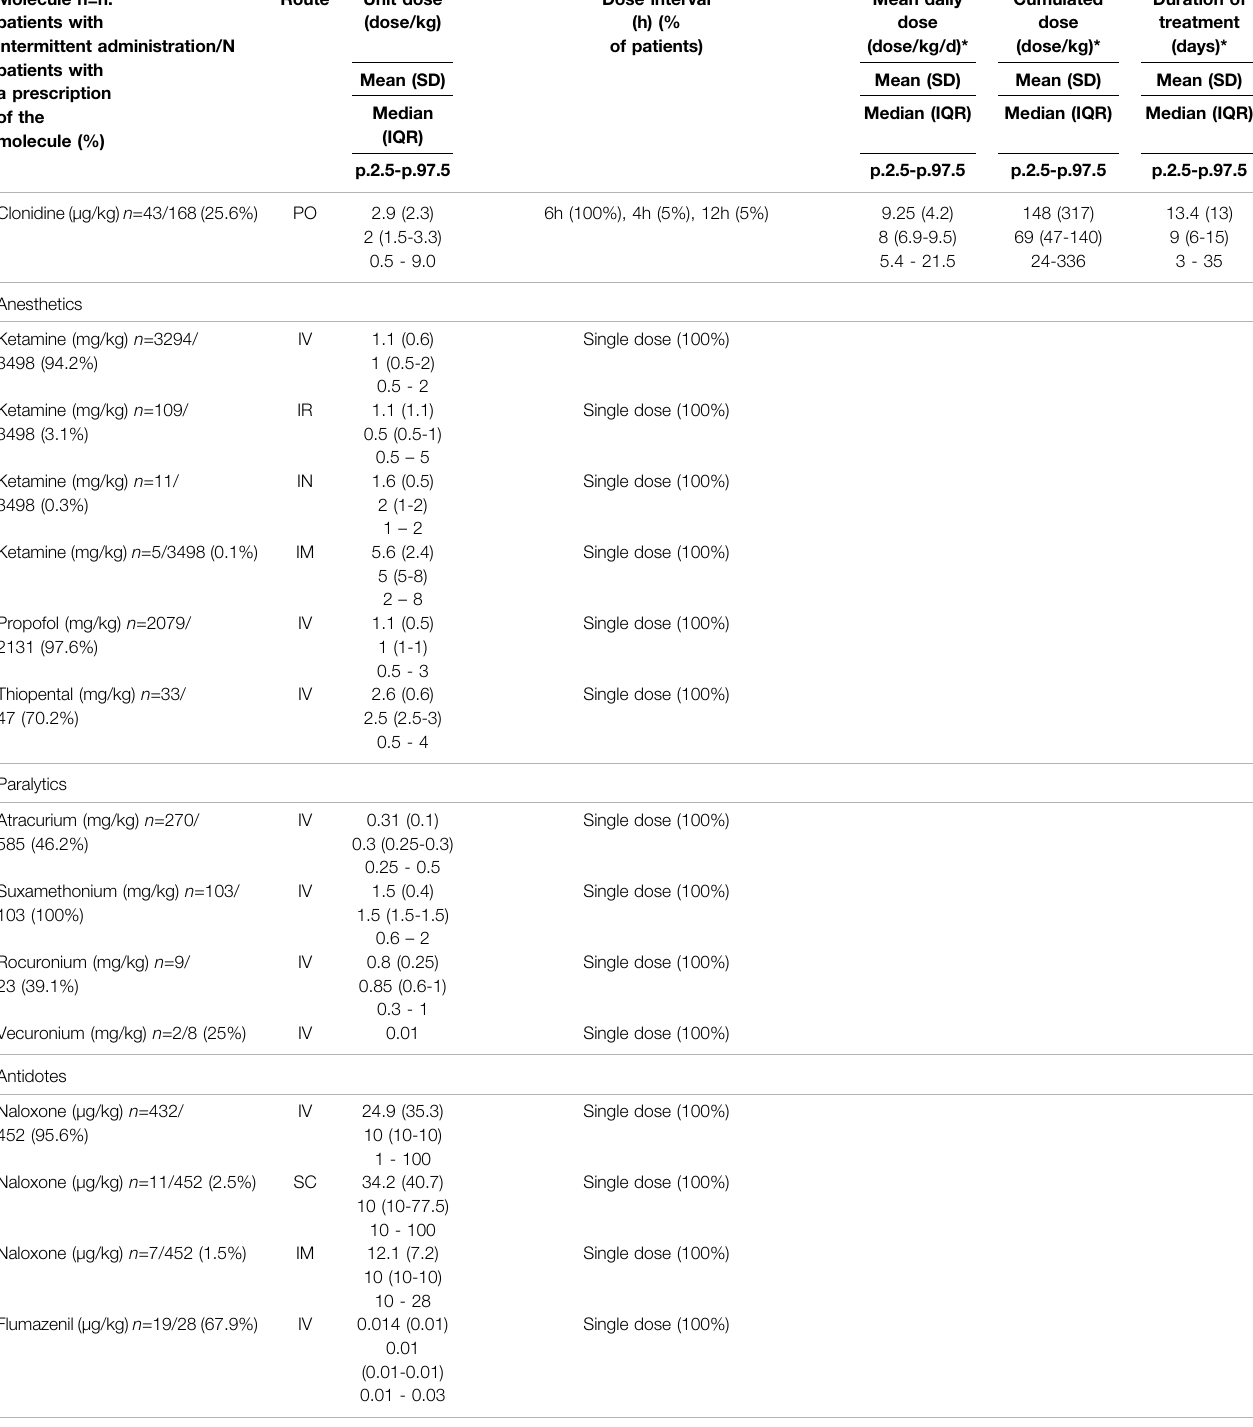
TABLE 4 | ( Continued ) Description of doses and duration of treatment for drugs prescribed as single doses or intermittent administration Molecule n=n. patients